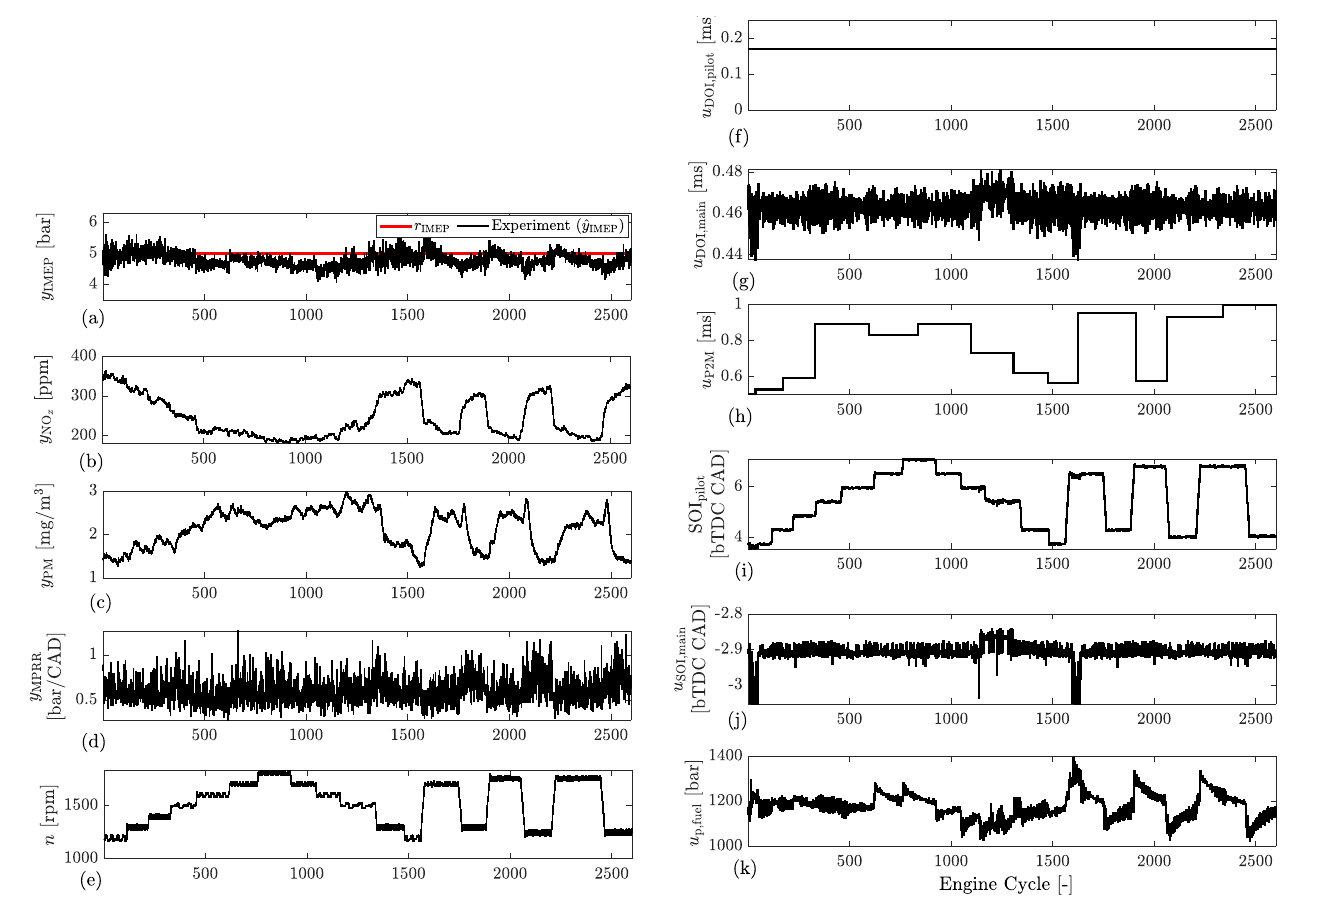
Figure 12. Experimental results: step changes in engine speed—( a ) indicated mean effective pressure (IMEP), ( b ) nitrogen oxide (NO x ), ( c ) Particle Matter (PM), ( d ) maximum pressure rise rate (MPRR), ( e ) engine speed, ( f ) duration of injection (DOI) of pilot injection, ( g ) DOI of main injection, ( h ) du- ration between end of pilot injection and start of main injection, ( i ) start of injection (SOI) of pilot injection, ( j ) SOI of main injection, ( k ) fuel rail